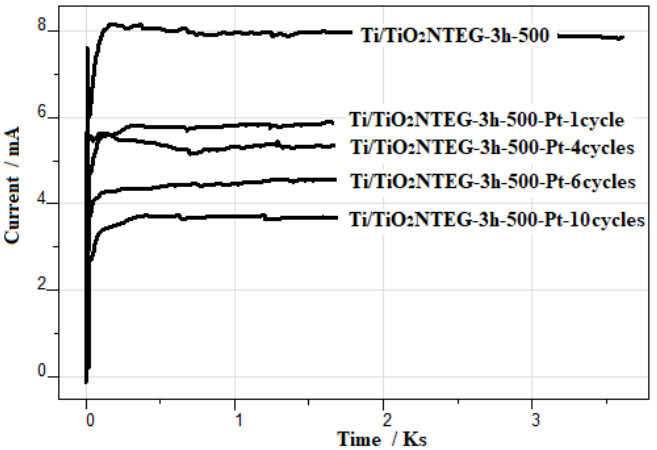
Figure 12. The photocurrent values of Ti/TiO 2 NTEG-3h-500 and Ti/TiO 2 NTEG-3h-500-Pt-Xcycles electrodes in the same medium in which PEC paraquat degradation reactions were